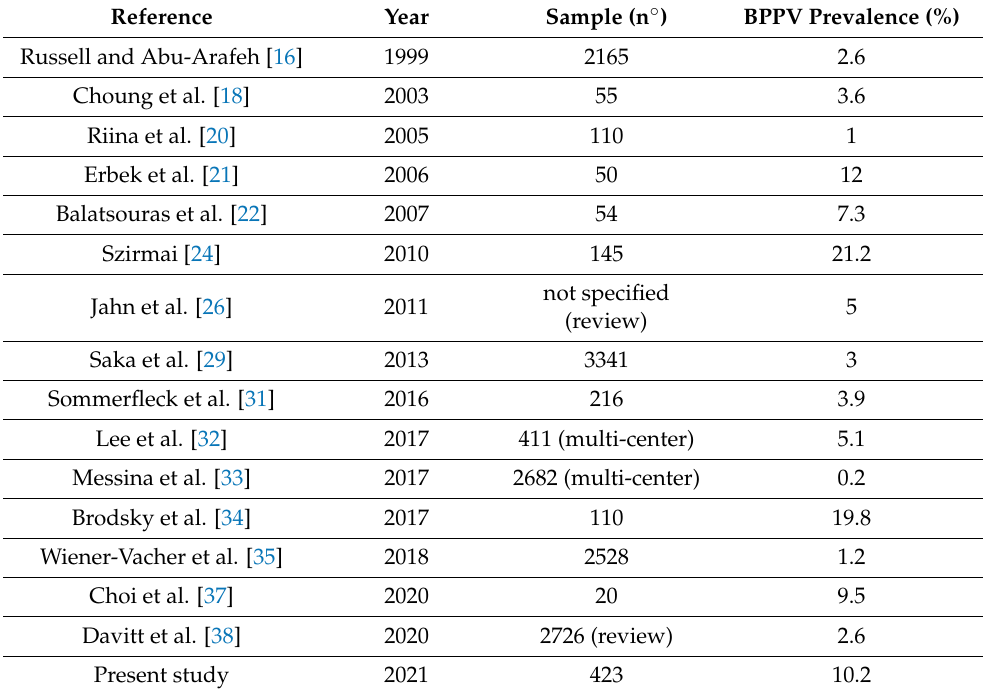
Table 3. Prevalence of BPPV in